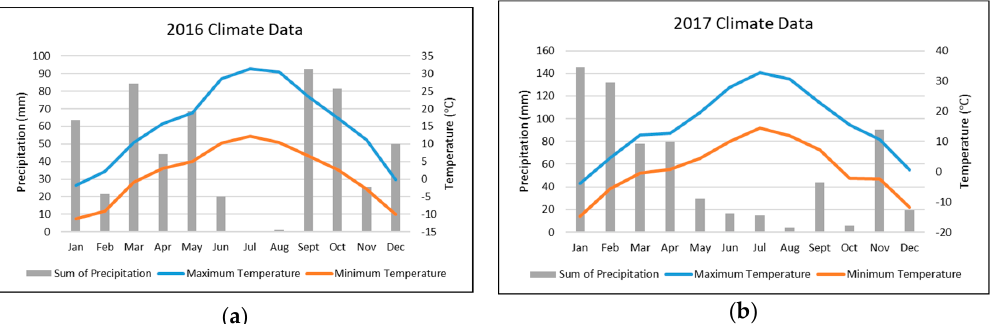
Figure 1. The temperature and precipitation during the evaluation of intermediate wheatgrass at the Utah State Univ. Evans farms: ( a ) 2016; ( b )